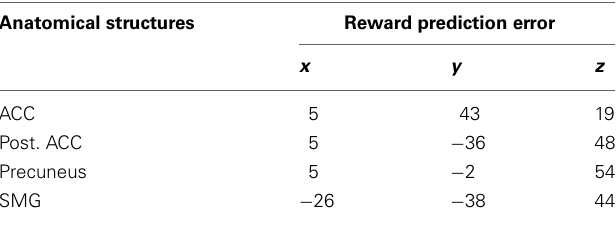
Table 2 | Sources localizations of ERFs found at S2 for all the subjects, in Talairach